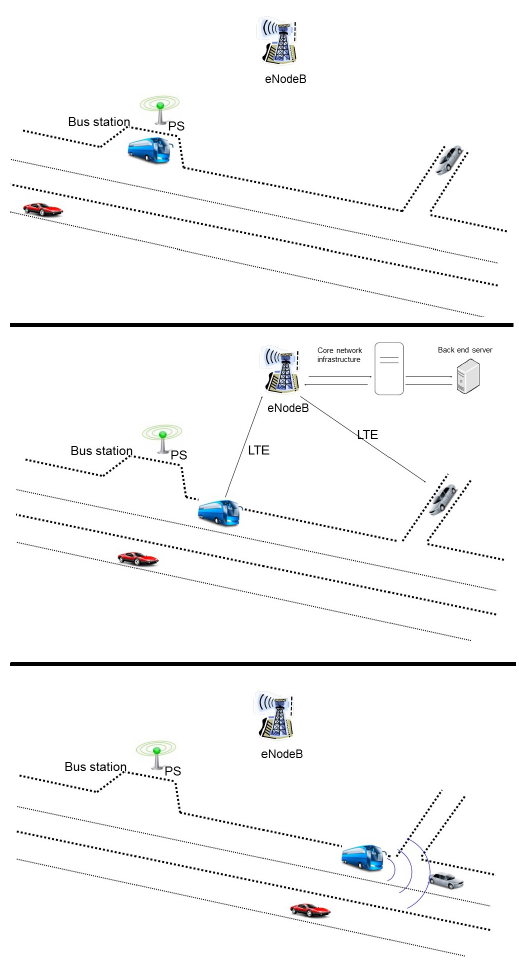
Figure 7. Application example of a Mobile